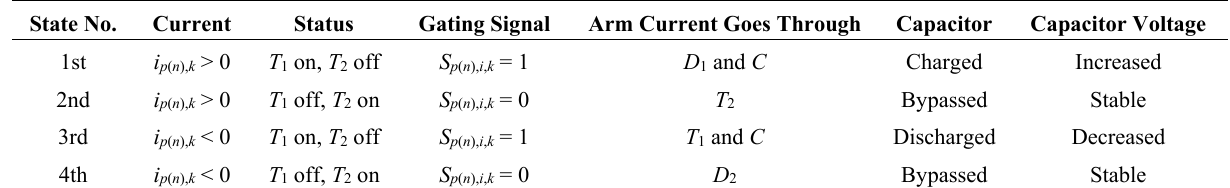
Table 1. Four Working Regions of Sub-Module in MMC.